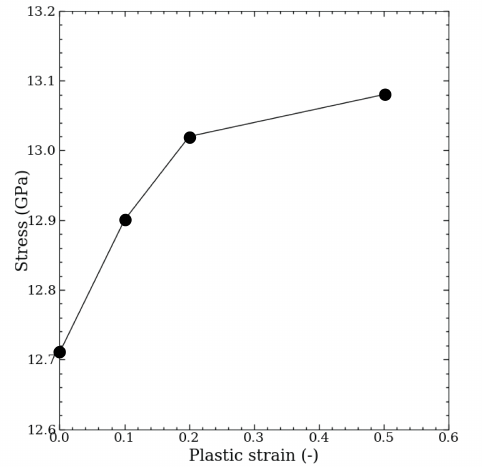
Figure 3. Compressive yield stress σ 0 vs. plastic strain ε p , as used in Equation